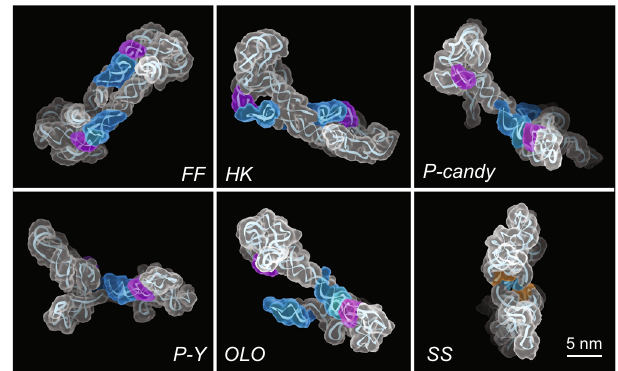
Fig. 3 | Formation of the rCbl heterogeneous dimers through conserved RNA – RNA interaction motifs. Five of the six dimer classi fi cations observed by AFM exhibitone ortwoKLinteractions between L5/P5 (purple)and L13/P13 (blue): fully-formed ( FF ), hook ( HK ), P - candy , P - Y , andone-leg-out ( OLO ). The shoulder-to- shoulder ( SS ) dimer forms through symmetrical tetraloop (cyan) — minor-groove (orange) interactions. The AFM molecular surfaces used for structure calculation were derived from individual particles selected from the AFM image in Fig.